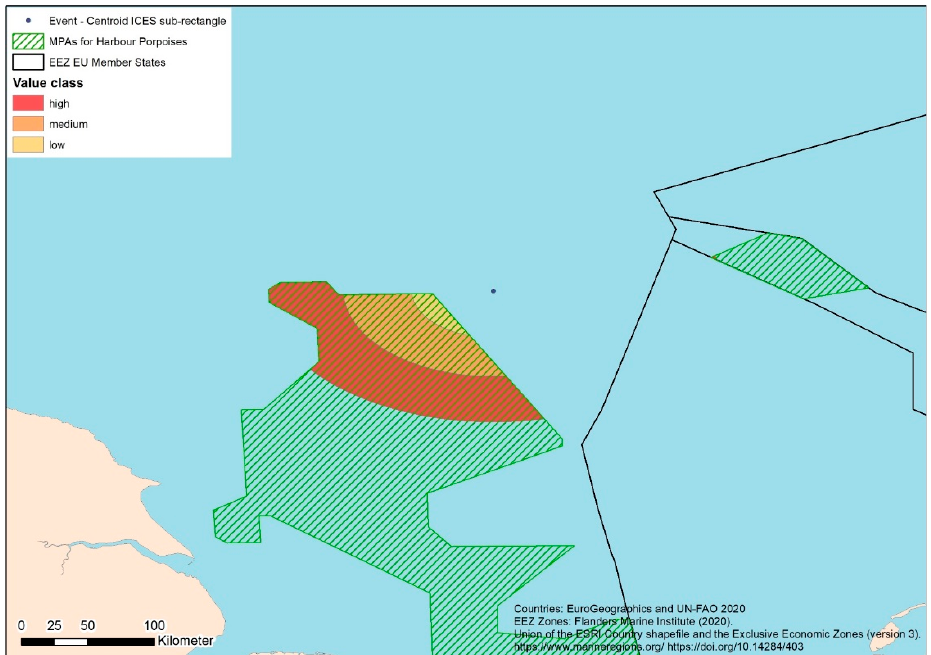
Figure 4. Exposed area (MPA Southern North Sea) of interest depending on value code class. Table 4. Percentage of exposed area (MPA Southern North Sea) of interest as shown in Figure 4 and depending on value code